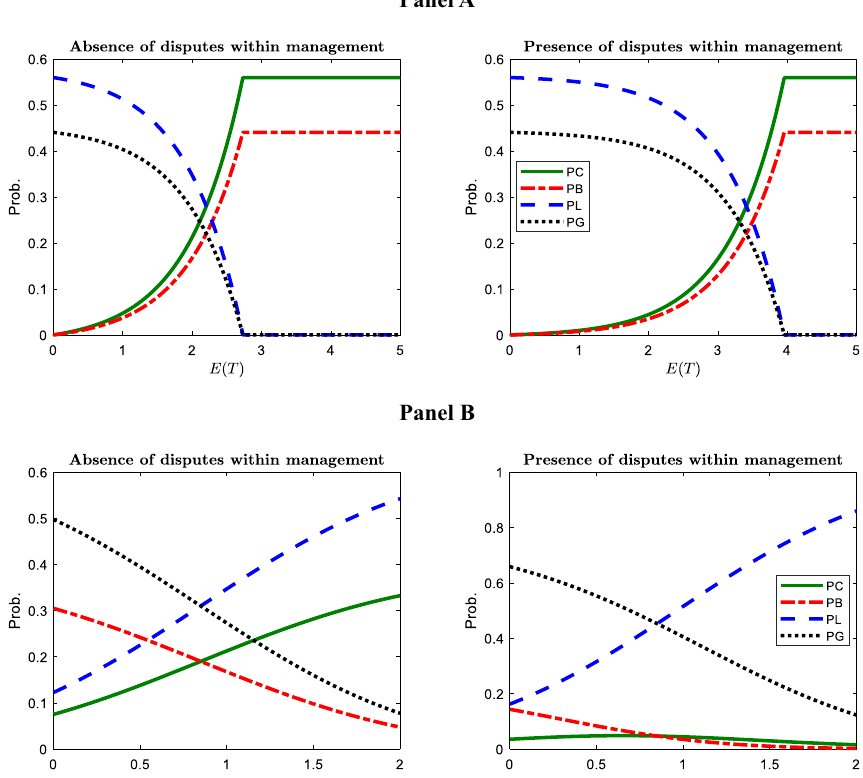
Fig. 5 Disputes within management: Probabilities of the four strategies under ambiguity. PC , PB , PL , and PG represent the probabilities of pursuing compulsive, buy‑and‑hold, leapfrog, and laggard strategies, respectively. To obtain conservative results, we choose a low level of ambiguity ( c = 0.4 ) as executive managers’ perceived ambiguity. Panels A and B show the innovation strategies for varying E ( T ) and for varying µ , respectively. Compared with no disputes within management (left graphs), PL and PG rise but PC and PB decline when disputes are present (right